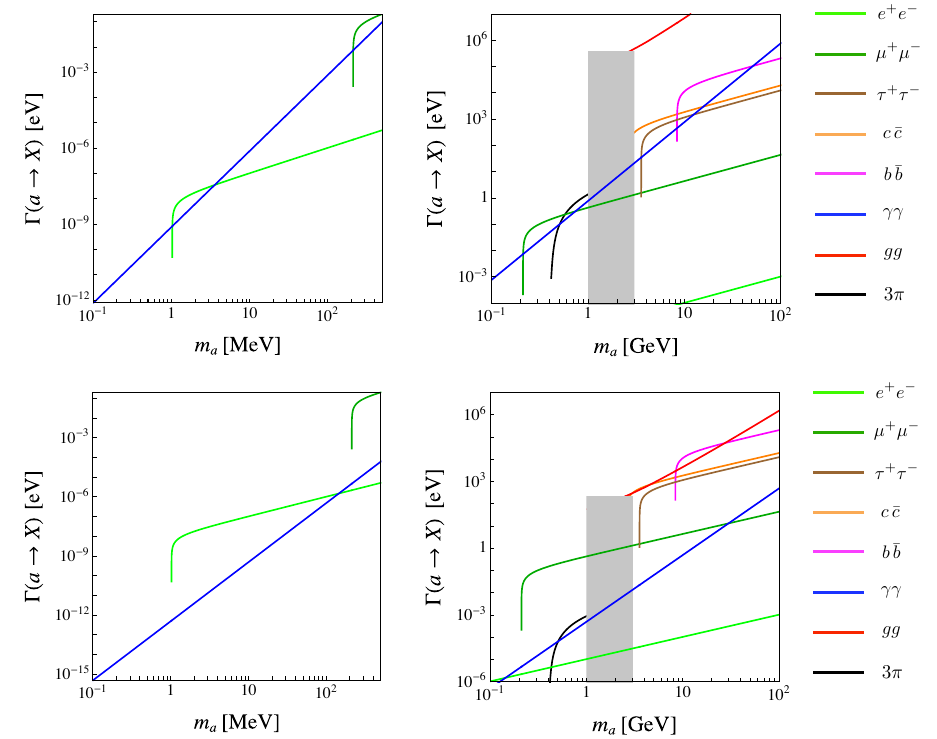
Figure 3 . ALP decay rates into pairs of SM particles obtained by setting the relevant e(cid:11)ective Wilson coe(cid:14)cients to 1 (top), or by setting the ALP-fermion couplings to 1 and the ALP-boson couplings to 1 = (4 (cid:25) 2 ) (bottom). The gray area between 1 and 3 GeV shows the region in which various exclusive hadronic (and di(cid:14)cult to calculate) decay channels such as a (cid:26)(cid:26) open up. In ! this interval the rate (cid:0)( a hadrons) is expected to interpolate between the black and red lines. ! The rates for decays into heavy-(cid:13)avor jets are shown